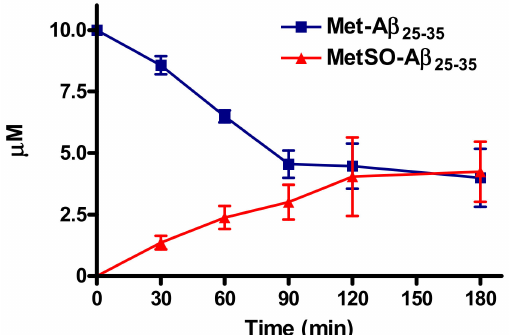
Figure 3. Time course of A β 25-35 oxidation by peroxymonocarbonate. To a reaction mixture containing 10 µ M A β 25-35 in 0.1 M phosphate bu ff er, pH 7.4, and 0.1 mM DTPA, peroxymonocarbonate was added at 0.8 mM final concentration. At various time intervals of incubation at 37 ◦ C, the reaction was stopped by addition of catalase (400 U / mL) and the reaction products were analyzed by HPLC.